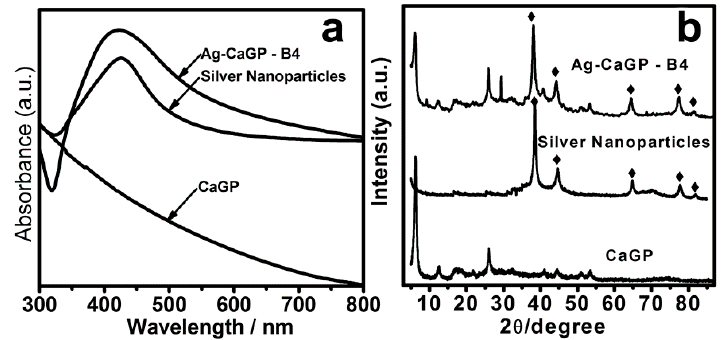
Figure 1. ( a ) UV-Vis ( b ) XRD pattern of Ag-CaGP (B4 group) nanocomposite, silver nanoparticles, and CaGP.